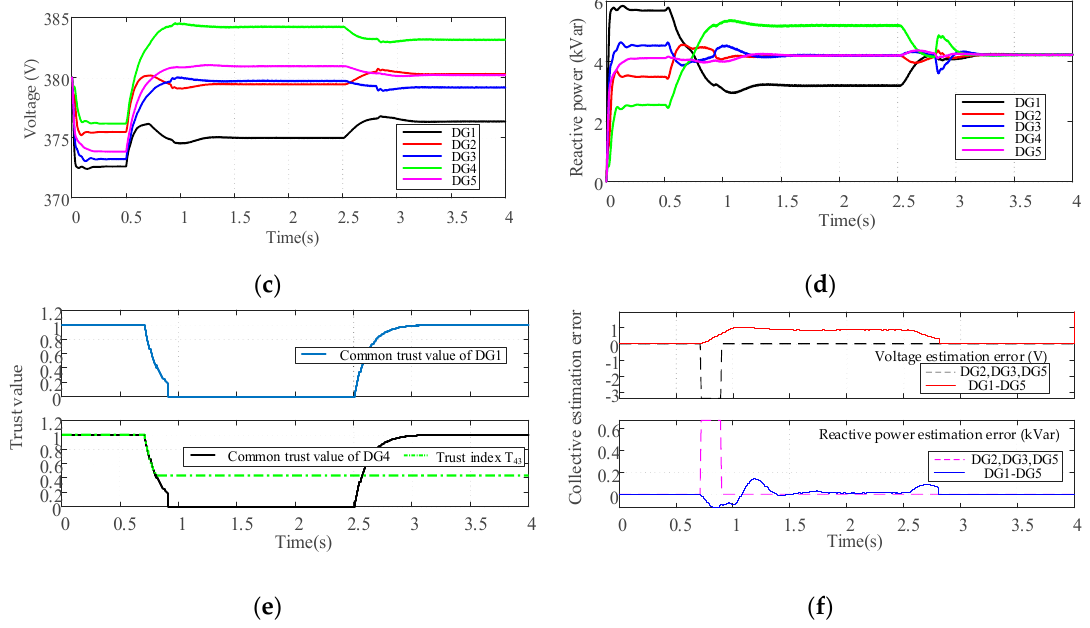
Figure 10. Performance of the proposed control scheme with multiple attackers and colluding attack: ( a ) Average voltage estimates; ( b ) Average reactive power estimates; ( c ) Voltages of DGs; ( d ) Reactive power of DGs. ( e ) Common trust values of DG1 and DG4; ( f ) Collective estimation error.